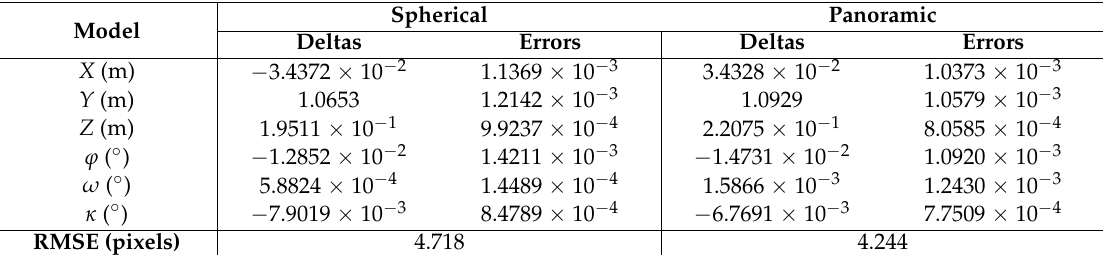
Table 3. Registration results based on the spherical and panoramic camera models.